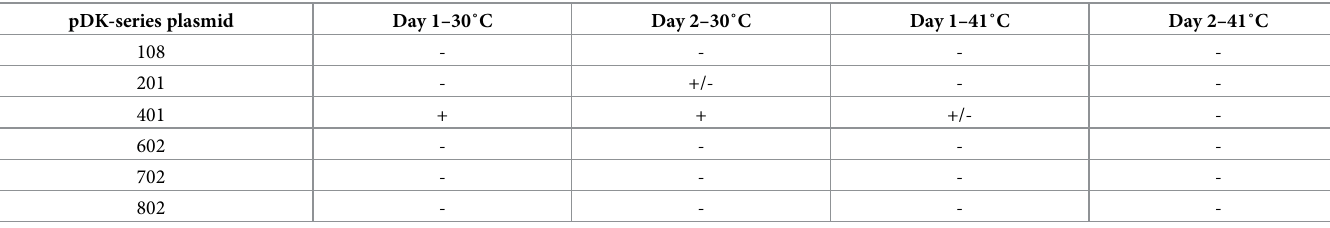
Table 4. Microscopic observation of PHA granules in E . coli DH5 α (pUMS, pDK-plasmid). pDK-series